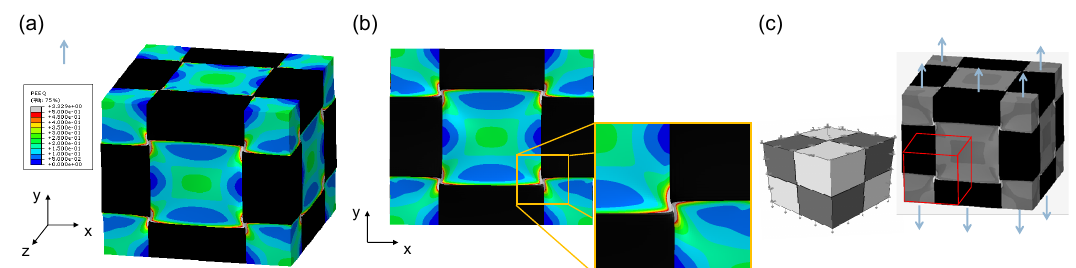
Figure 22. Plastic equivalent strain distribution in DP5-chess-board assuming ( a ) 3D morphology and its ( b ) respective distribution on the x-y plane. ( c ) Microstructure and load configuration used for the